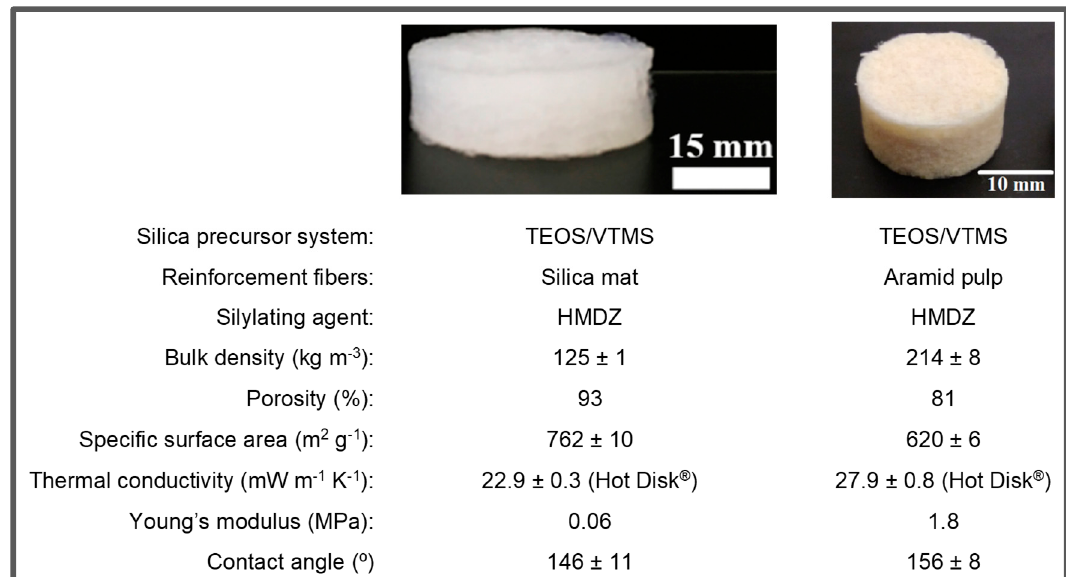
Figure 1. Aerogels from AerogelDustFree ( left ) and AeroXTreme ( right ) projects (TEOS—tetraethyl orthosilicate; VTMS—vinyltrimethoxysilane;